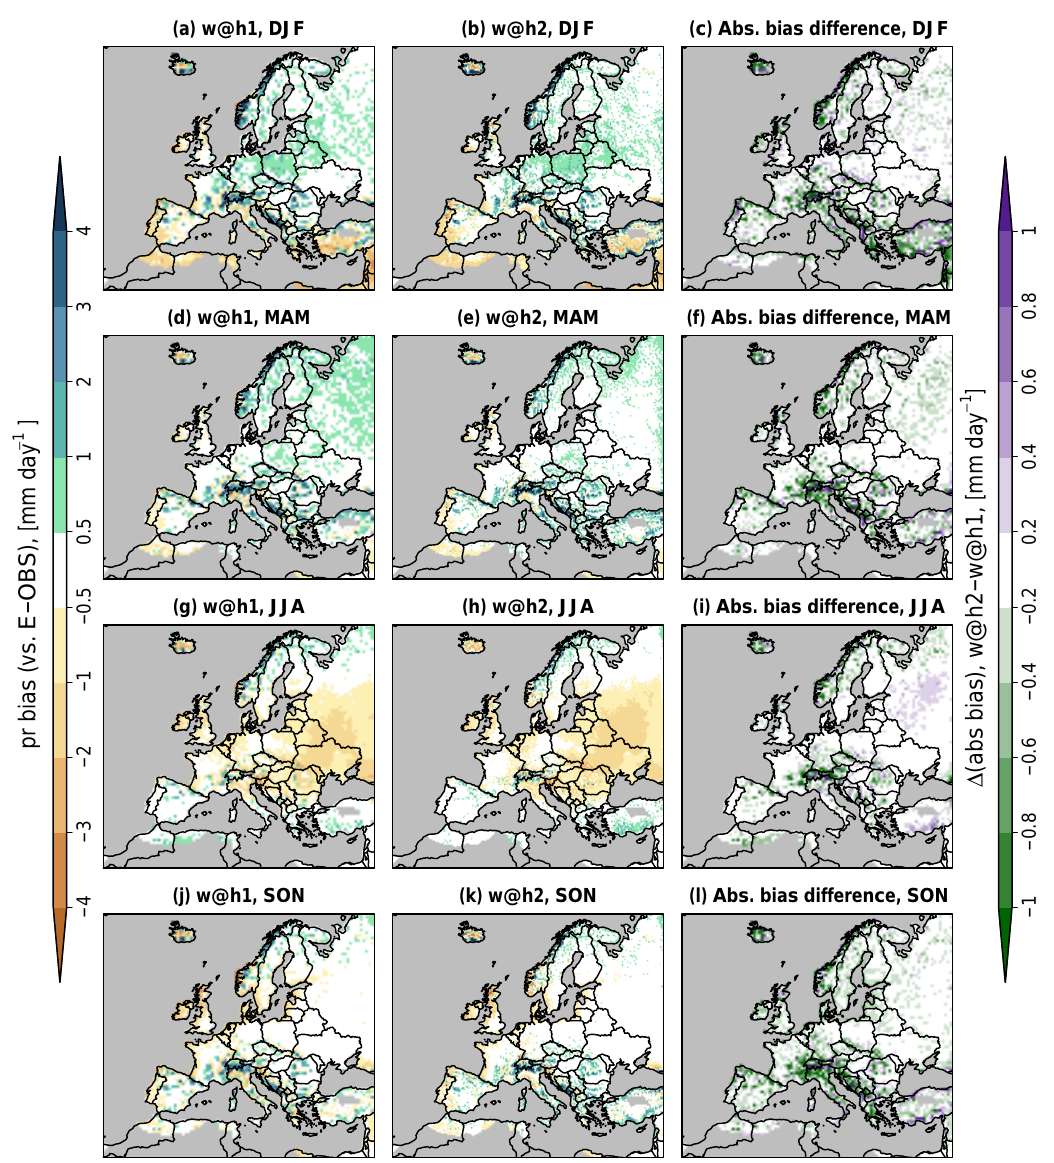
Figure 8. Same as Fig. 6 but for precipitation, in mmday − 1 . See Supplement Fig. S13 for these biases in relative